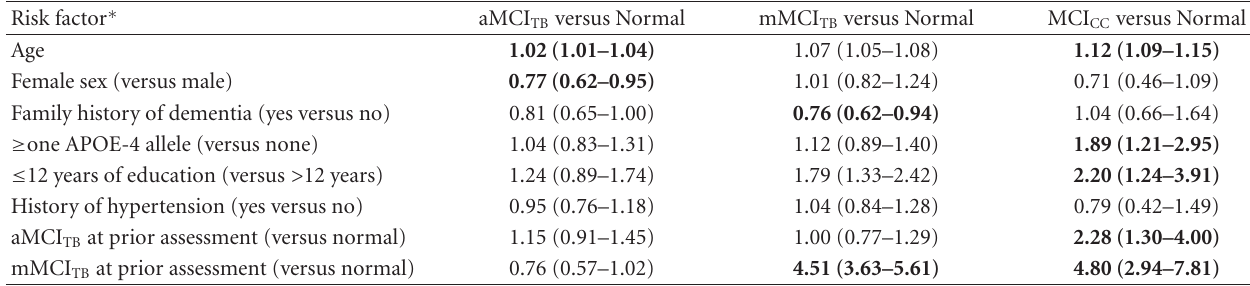
Table 4: Estimated relative risks and 95% confidence intervals for one-step transitions to test-based amnestic MCI (aMCI TB ), test- based mixed MCI (mMCI TB ), or clinical consensus MCI (MCI CC ) versus the base state of normal cognition (bolding denotes statistical